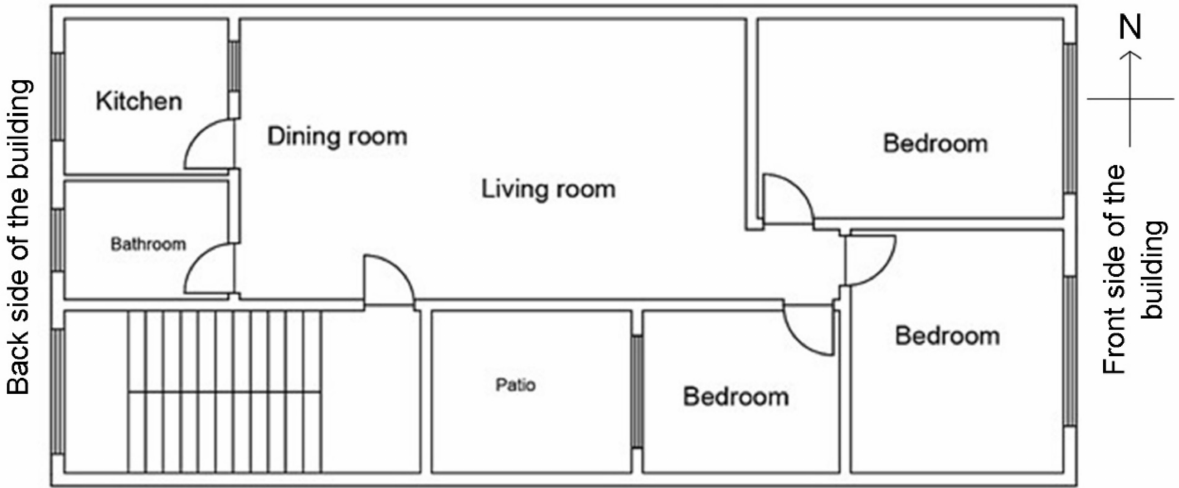
Figure 2. Floor plan of the case building, adapted from